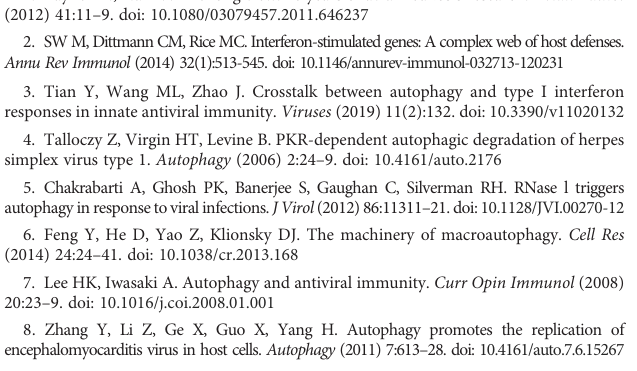
SUPPLEMENTARY TABLE 1 Primers used for qRT-PCR SUPPLEMENTARY TABLE 2 The function annotation, ontology classi fi cation, biological process analysis, molecular functions analysis, and KEGG pathway analysis of candidate CH25H- interacting